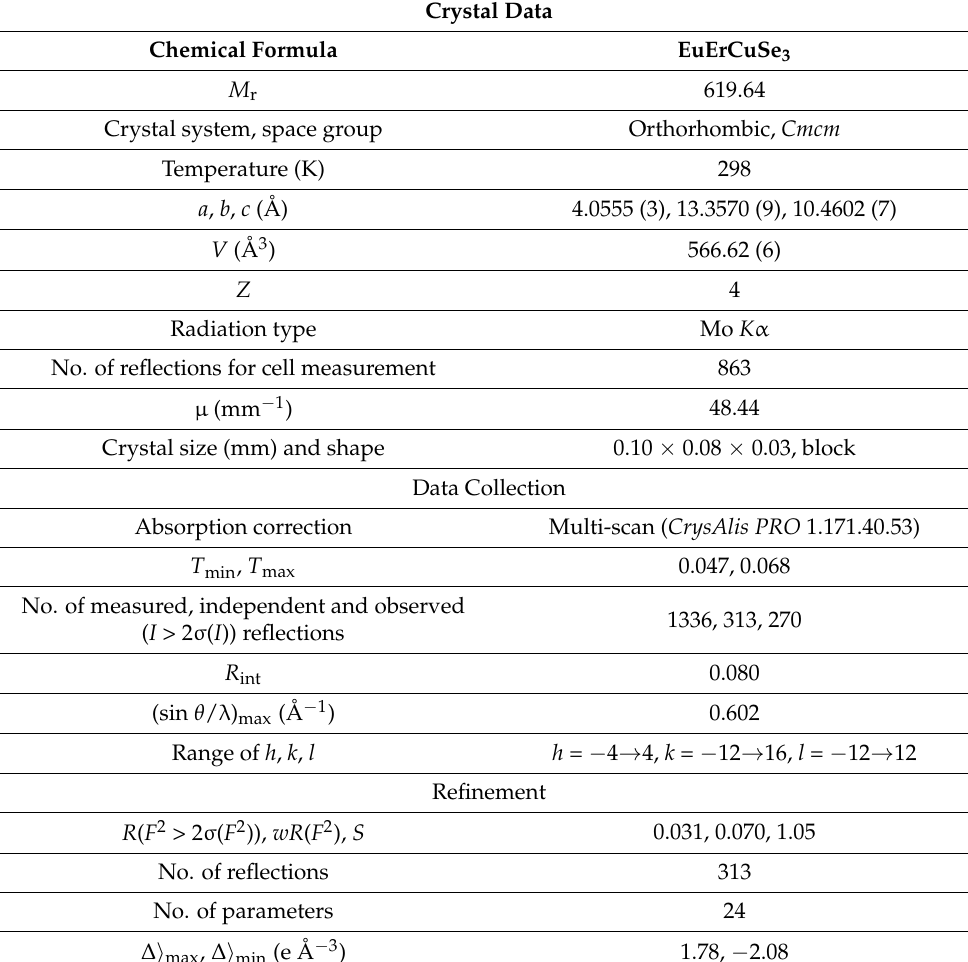
Table 1. Main parameters of data collection and crystal structure